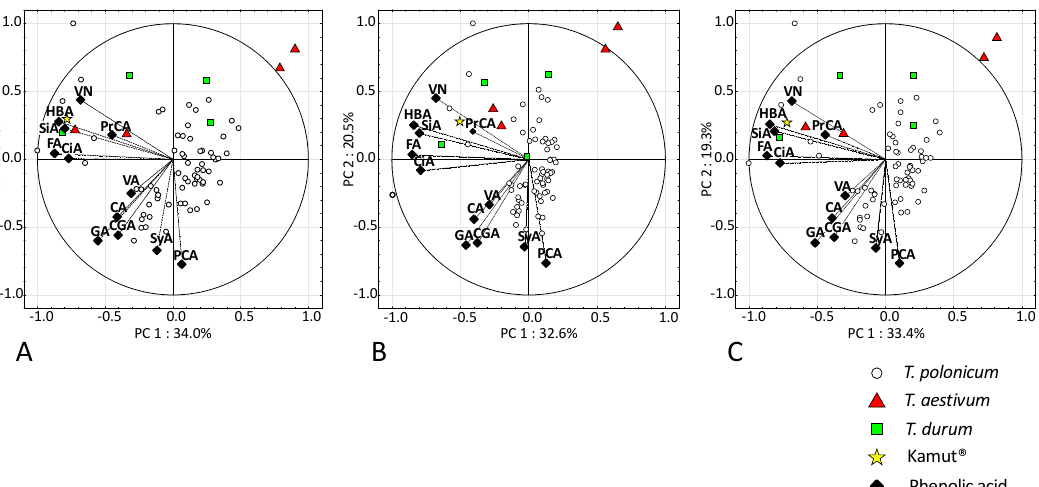
Figure 5. Biplots presenting the results of the principal component analysis for the concentrations of bound phenolic acids and vanillin in the flour ( A ), bran ( B ), and grain ( C ) of the analyzed wheat